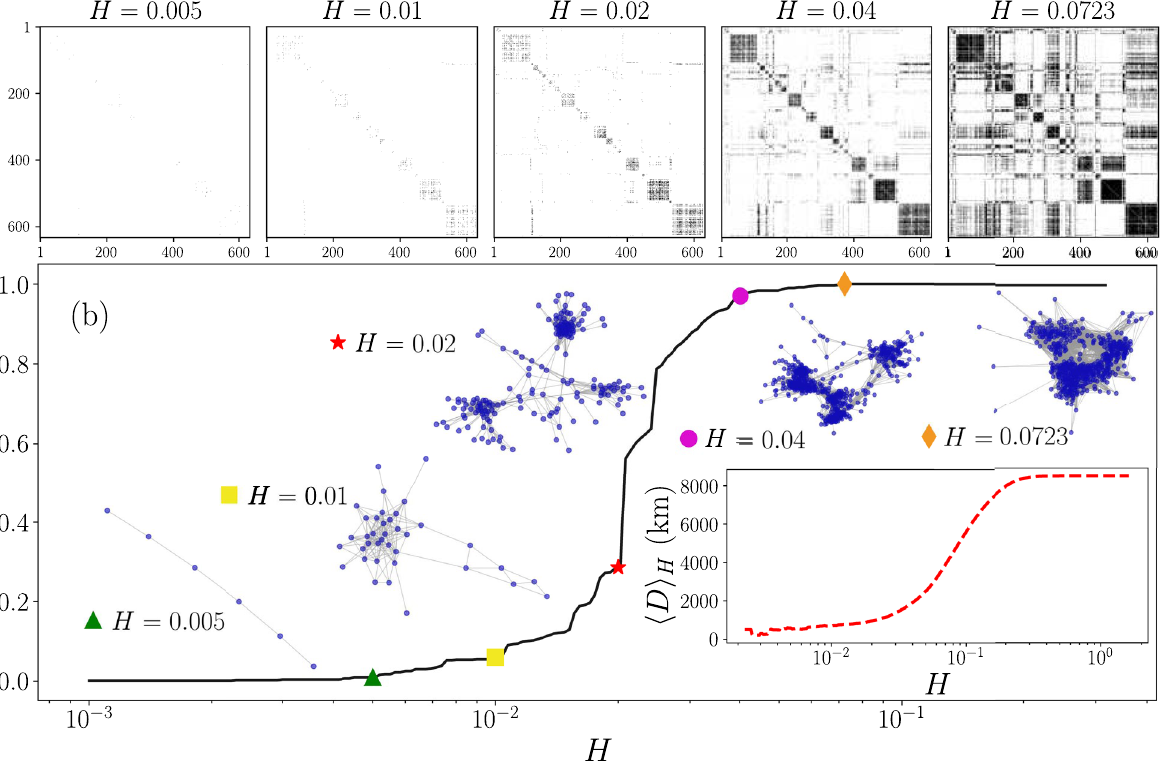
Figure 5. Similarity networks generated using different threshold values H . ( a ) Adjacency matrices A ( H ) with elements given by Eq. (4) using the values H ∈ { 0.005, 0.01, 0.02, 0.04, 0.0723 } , binary entries A ij ( H ) are depicted in white for 0 and black for 1. ( b ) Fraction of nodes in the largest connected component ν LCC as a function of H in the interval 0.001 ≤ H ≤ 0.32 . The largest connected component of the networks generated with A ( H ) in panel ( a ) are presented and the inset shows (cid:31) D (cid:30) H calculated using Eq. (5). All figures were created using python 3.8 and the matplotlib (3.5.0) package (https:// matpl otlib.